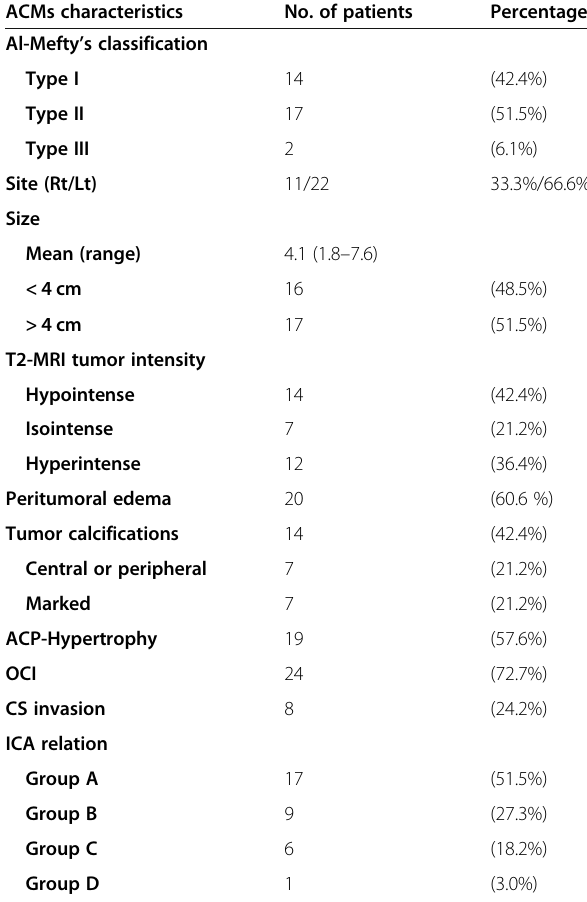
Table 2 Radiographic and surgical tumor characteristics of 33 patients